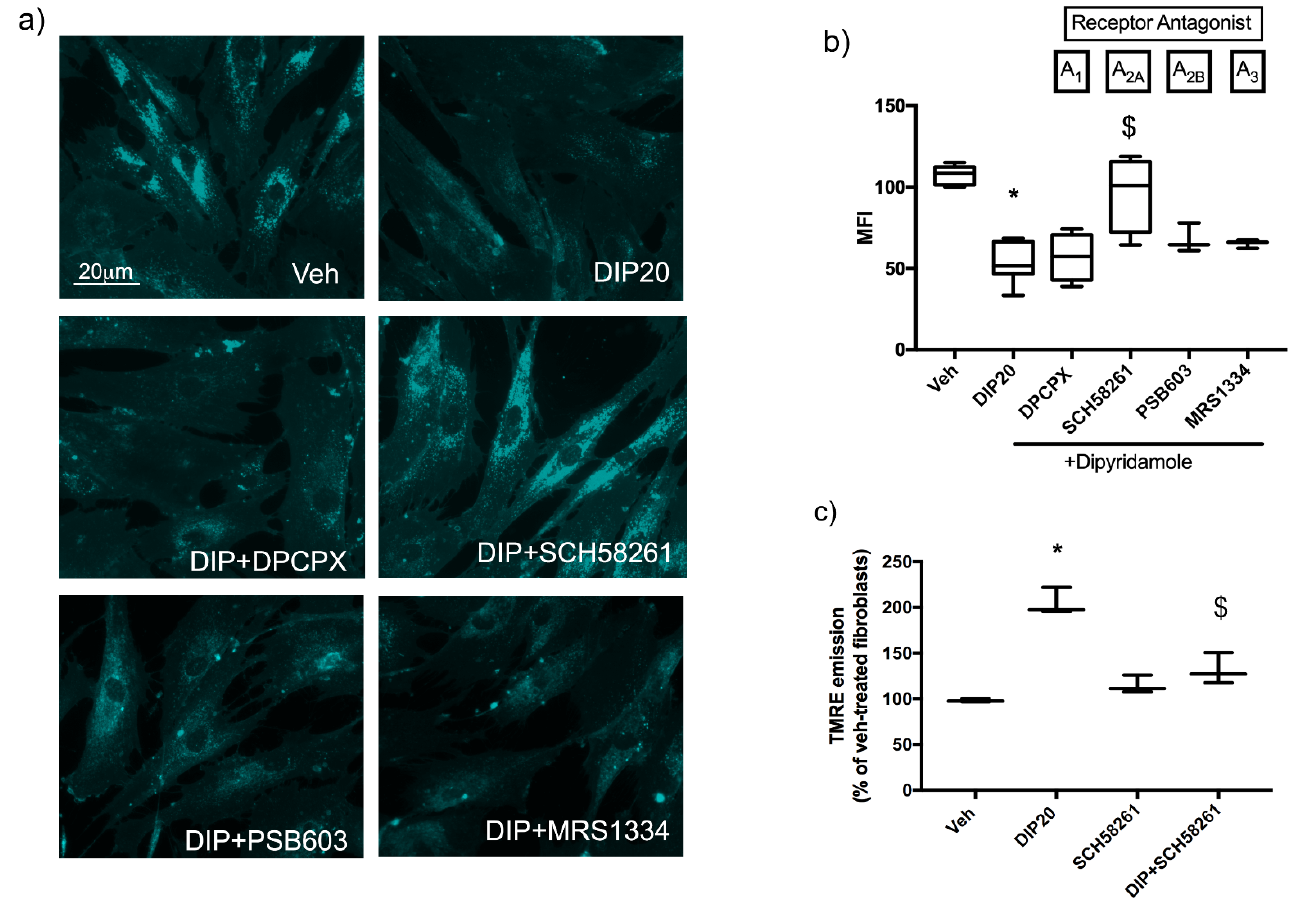
Figure 3. Effect of adenosine receptors inhibition on dipyridamole-mediated reduction in cholesterol accumulation and rescue of mMP. ( a ) Representative images of Filipin III-stained NPC1 fibroblasts (GM17926) treated with 20 µ M of dipyridamole (DIP20) alone or in combination with A 1 R (15 µ M DPCPX), A 2A R (10 µ M SCH58261), A 2B R (500 nM PSB603) and A 3 R (1 µ M MRS1334) antagonists. Scale bar=20µm. ( b ) Quantification of mean fluorescence intensity (MFI) of Filipin III staining, expressed as percentage of veh-treated cells; the A 2A R antagonist SCH58261 inhibited the effect of DIP20 on cholesterol accumulation ( n = 3–8 independent experiments). ( c ) Quantification of mean fluorescence intensity (MFI) of TMRE emission, expressed as percentage of veh-treated cells. The A 2A R antagonist SCH58261 inhibited the effect of DIP20 on mMP ( n = 3 independent experiments). * p < 0.05 vs. veh-treated; $ p < 0.05 vs. DIP20-treated cells after one-way ANOVA. Data are expressed as box-plots (whiskers from min to max values).